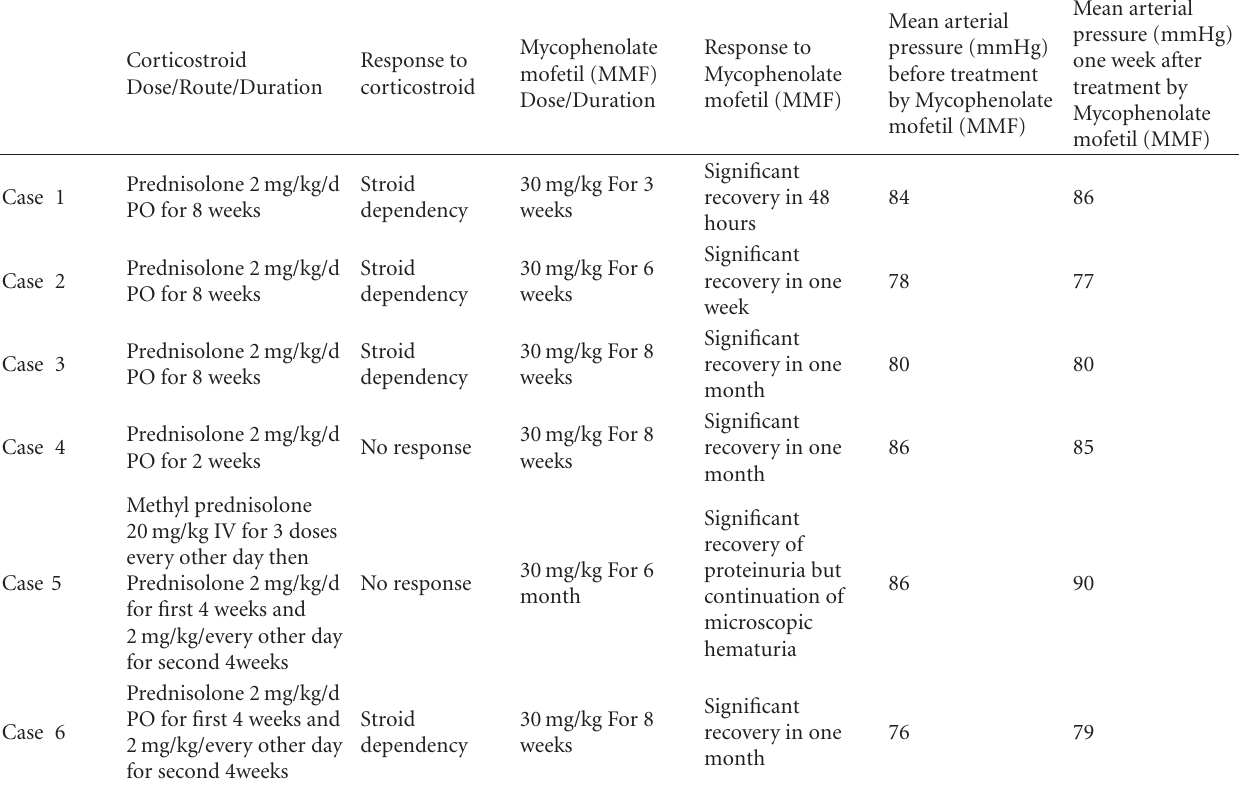
Table 3: Treatment protocols and outcomes of